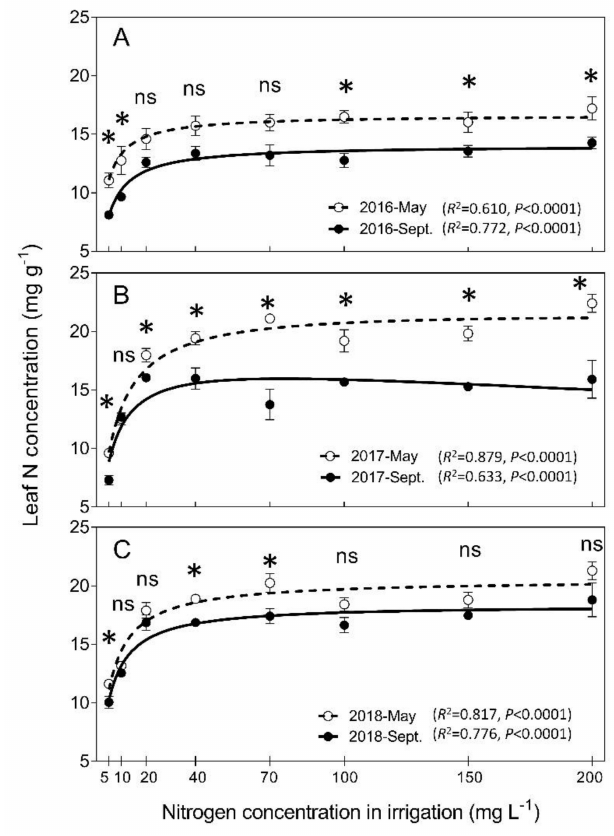
Figure 1. Nitrogen concentration in the leaves of pomegranate trees, as a function of fertigation N levels. ( A ) 2016; ( B ) 2017; ( C ) 2018. ns = not significant. Bars represent standard deviation (SD). Asterisk (*) defines a significant di ff erence between the dates, at the same N level. The line represents best fit regression. Regression line equations are presented in Table A1. Significance between treatments at each sampling date is presented in Table A2.